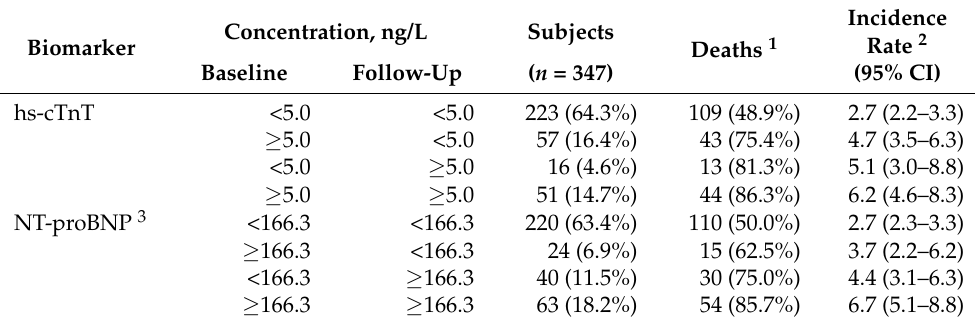
Table 2. Categories of changes in biomarker concentrations between baseline and one-year follow-up and mortality ( n = 347, 209